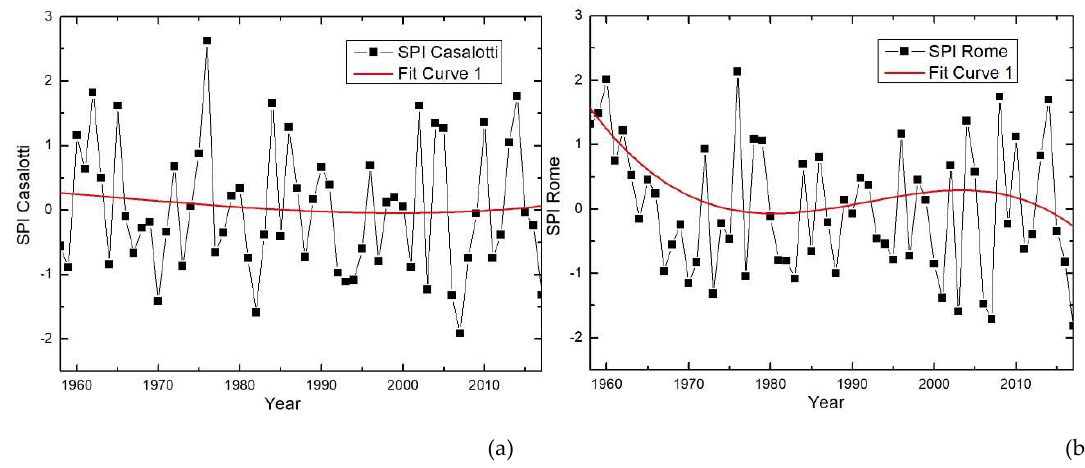
Figure 3. Time series of the annual SPI (broken lines) and 5-order polynomial fitting curves (red curves) in Casalotti ( a ) and Collegio Romano ( b ), by year, 1958–2017.